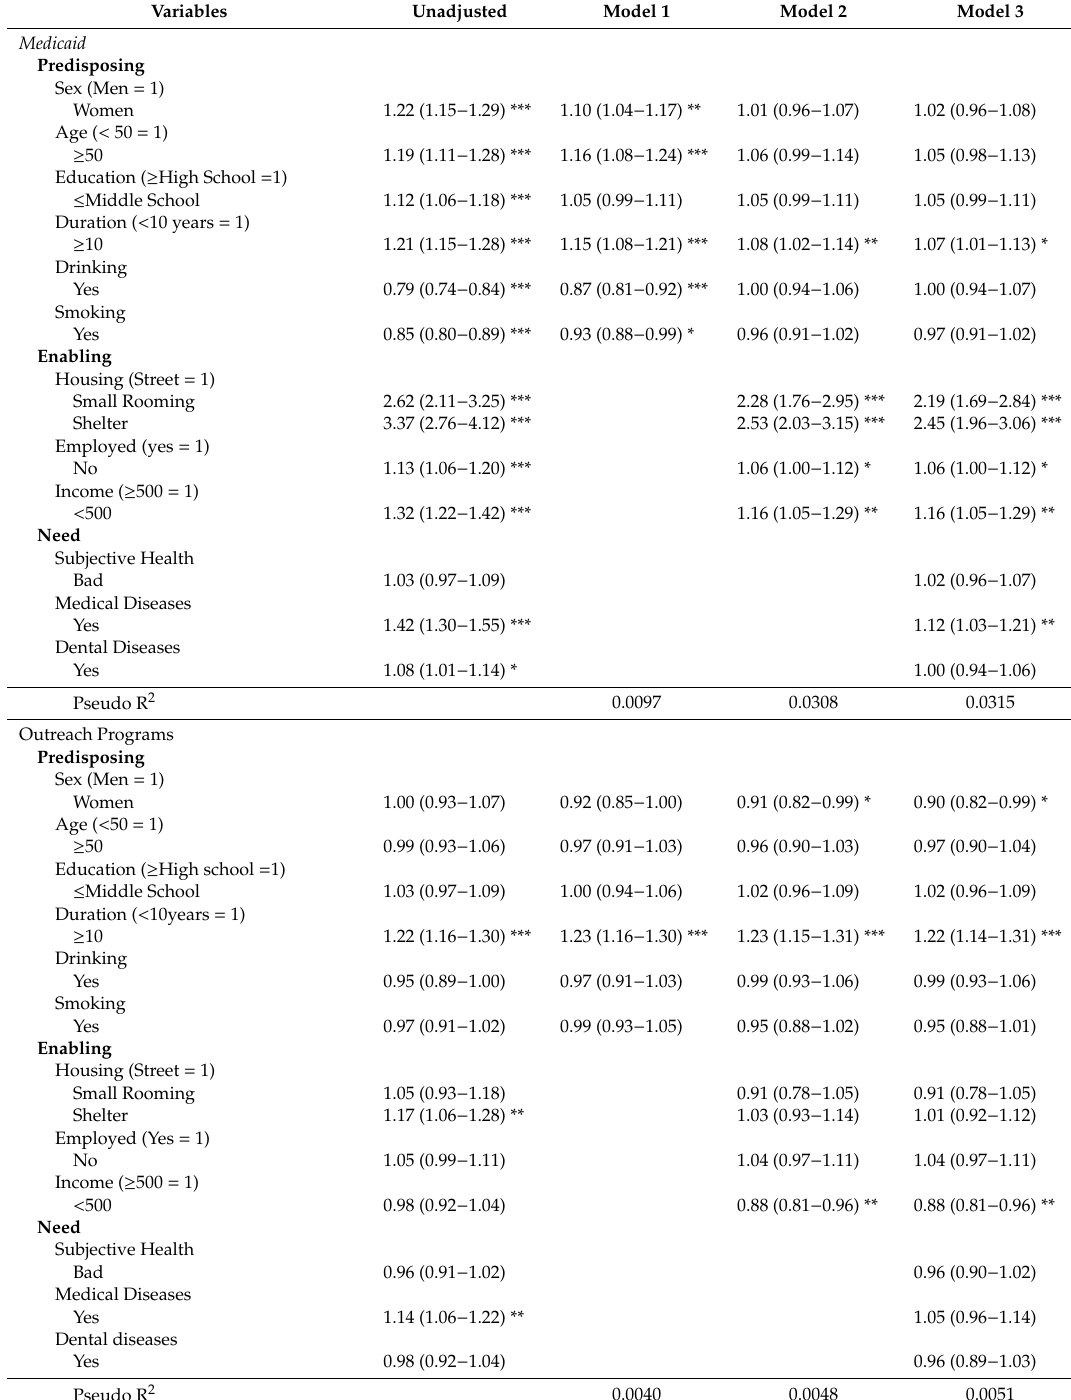
Table 4. Prevalence ratios (PRs) (95% CI) of the utilization of medical and dental services by three domains of Gelberg–Andersen behavioral model in homeless people, Seoul.